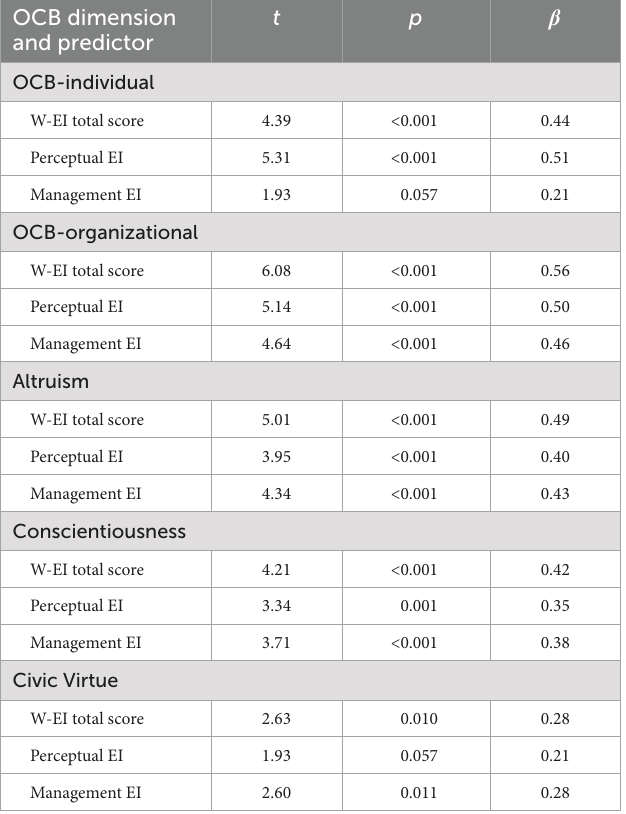
TABLE 1 Work-related emotional intelligence (W-EI) as a predictor of organizational citizenship behavior (OCB), simple regression results, Study